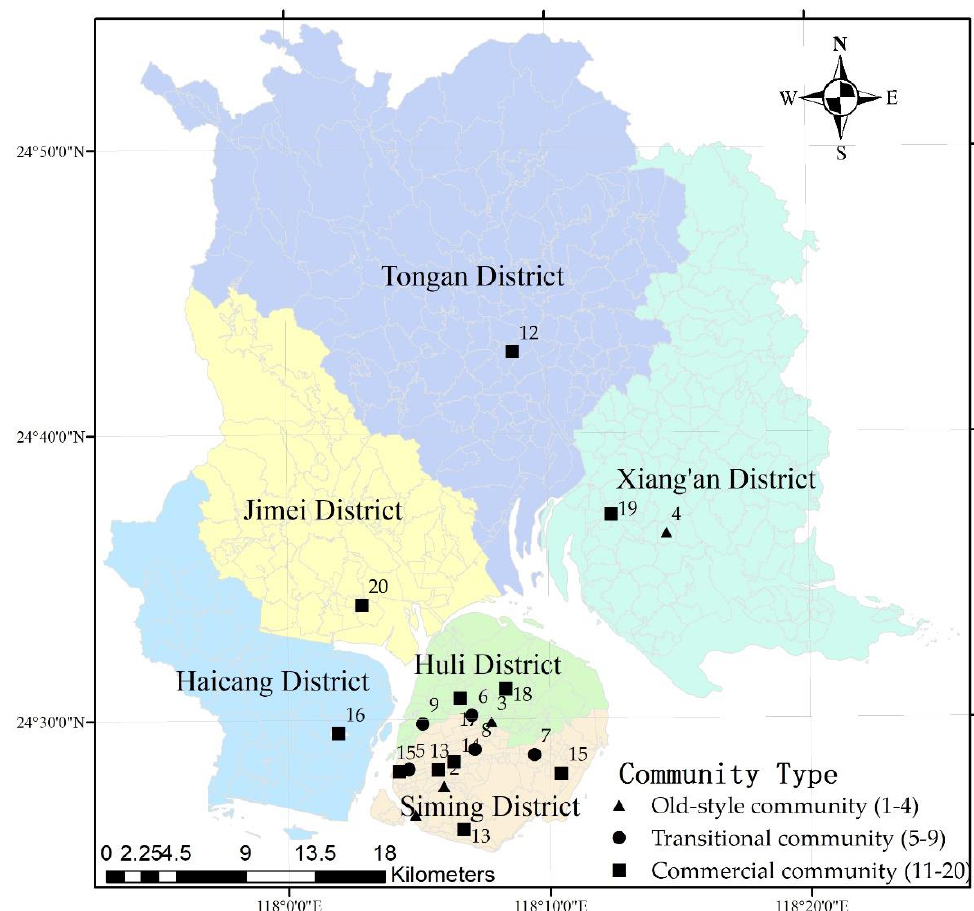
Figure 1. Distribution of surveyed communities in Xiamen City, China.